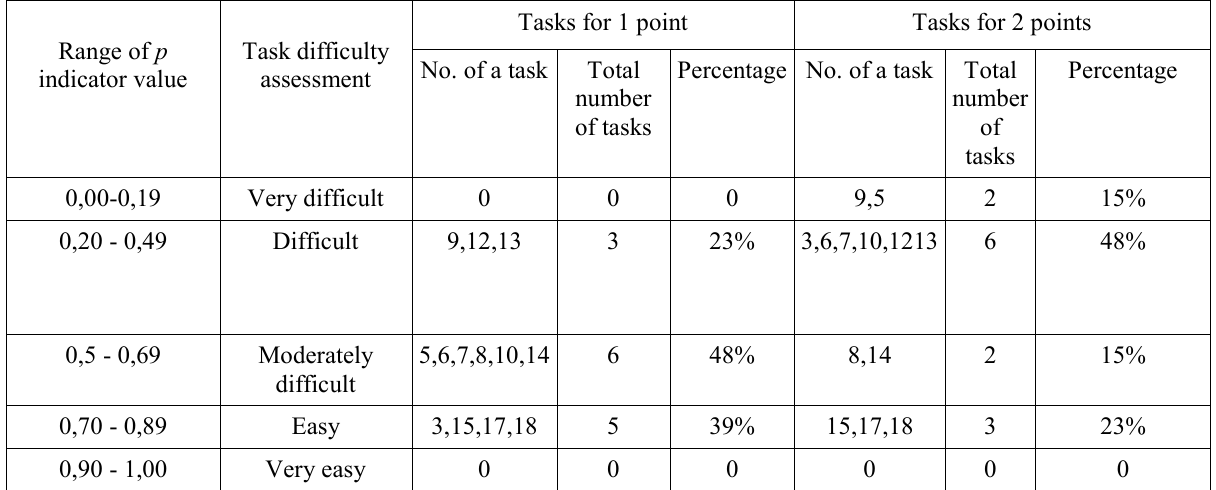
Values interpretation of task difficulty level